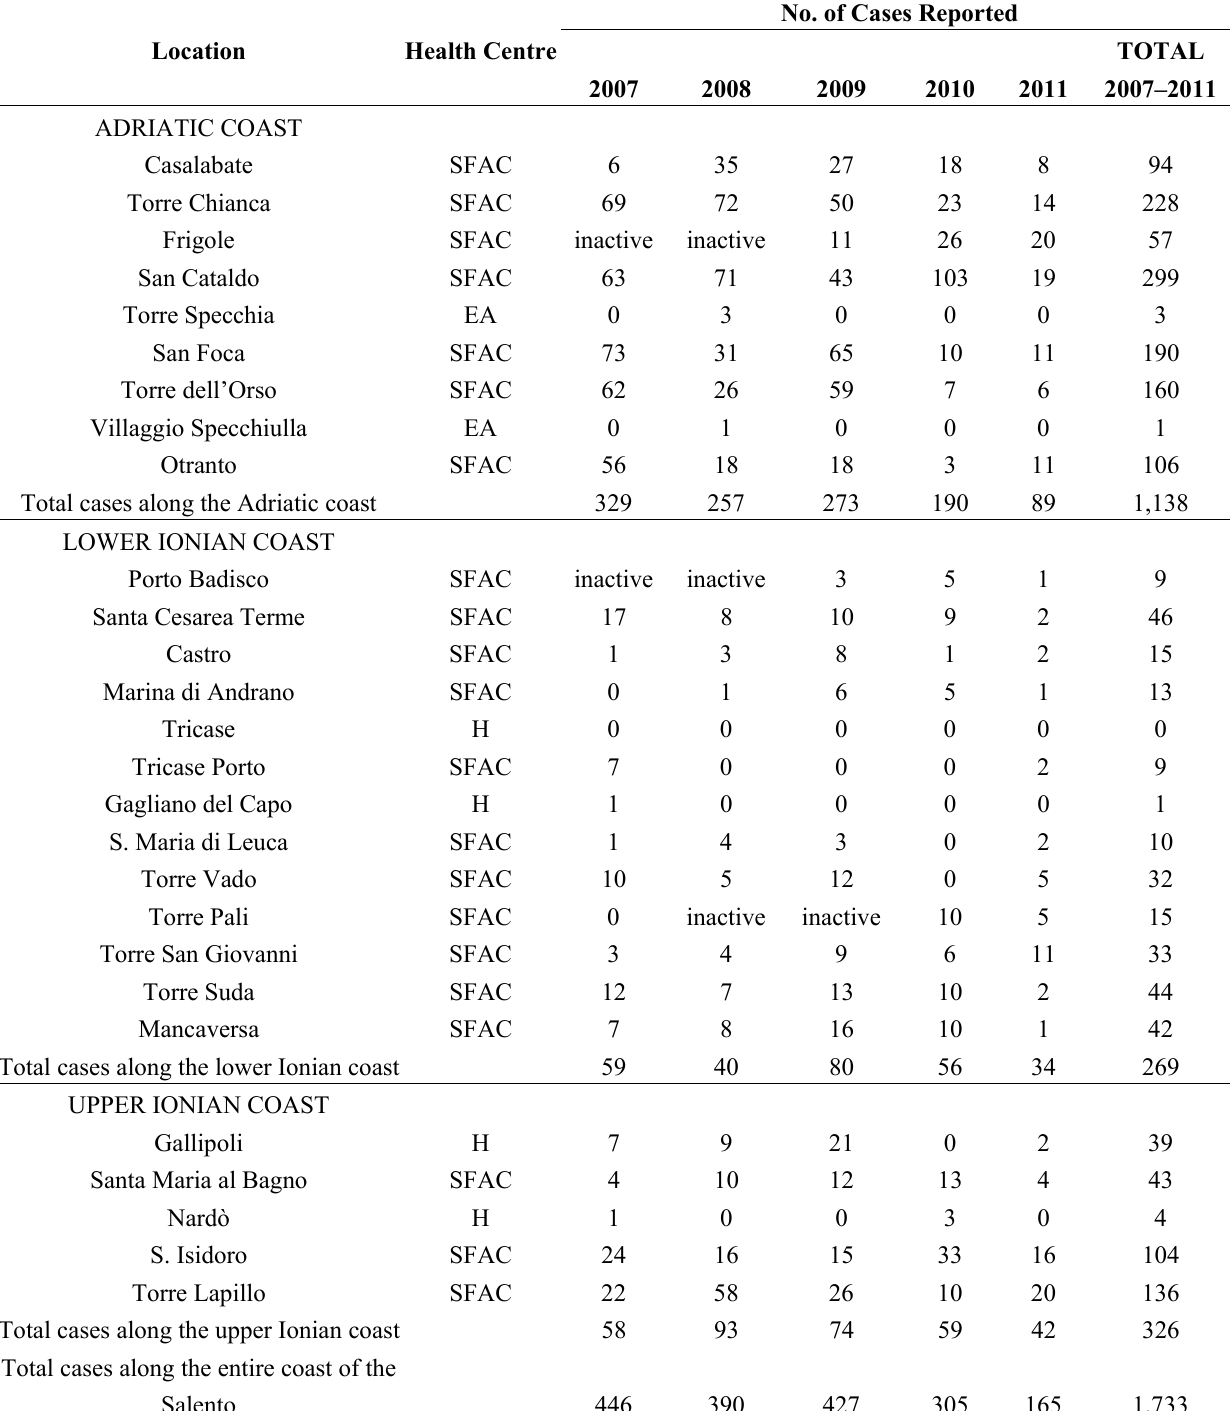
Table 1. Number of cases of jellyfish stings reported at health centres along the coast of the Salento peninsula (Italy) in the period 2007–2011 (SFAC: Summer First Aid Centre; H: Hospital; EA: Emergency